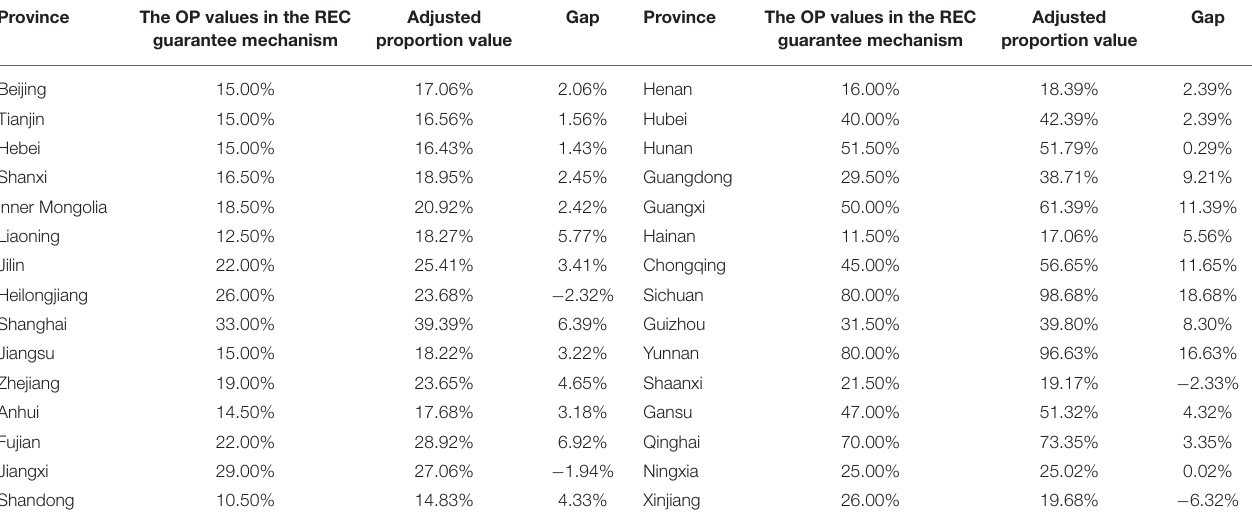
TABLE 5 | The OP values in the REC guarantee mechanism and adjusted proportion values of each province. Province The OP values in the REC Adjusted Gap Province The OP values in the REC guarantee mechanism proportion value guarantee